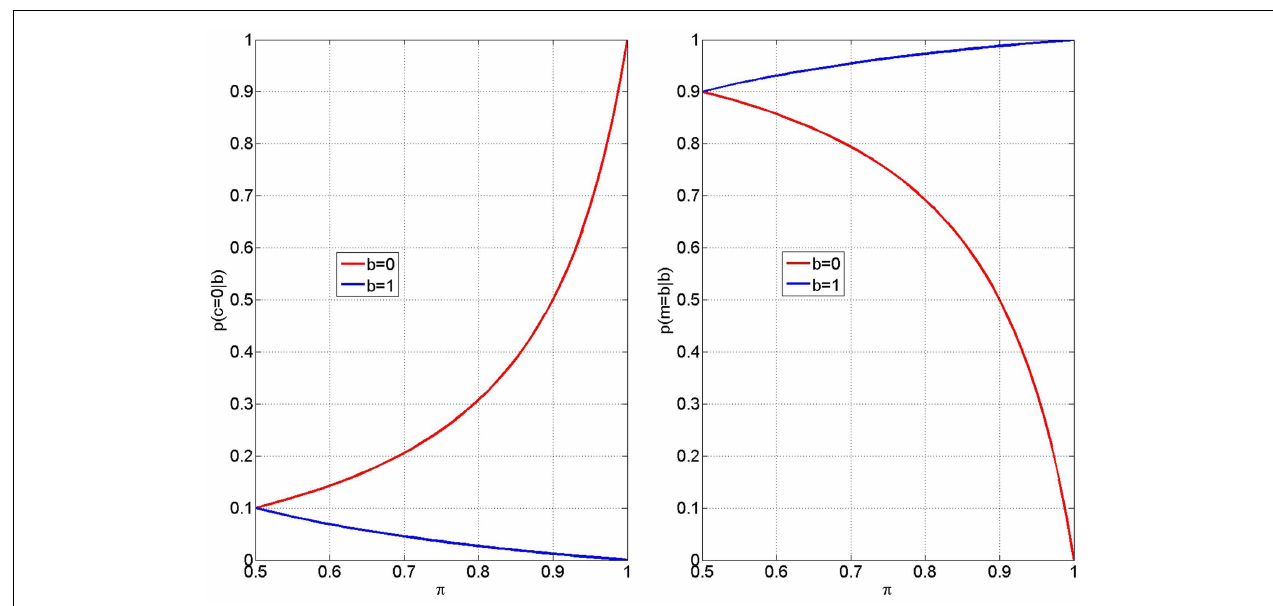
curves take on values 0 and 1 at π = 1 (perfect rule memory).The value 1 − β t determines the intercept at π = 0.5 and thus controls the gradient of each of the above effects. Me-focus (Right)The extent of a subjects “me-focus” is quantified by the probability p ( m = b | b ) shown here subsequent to error outcomes, b = 0 (red curve) and correct outcomes, b = 1 (blue curve).